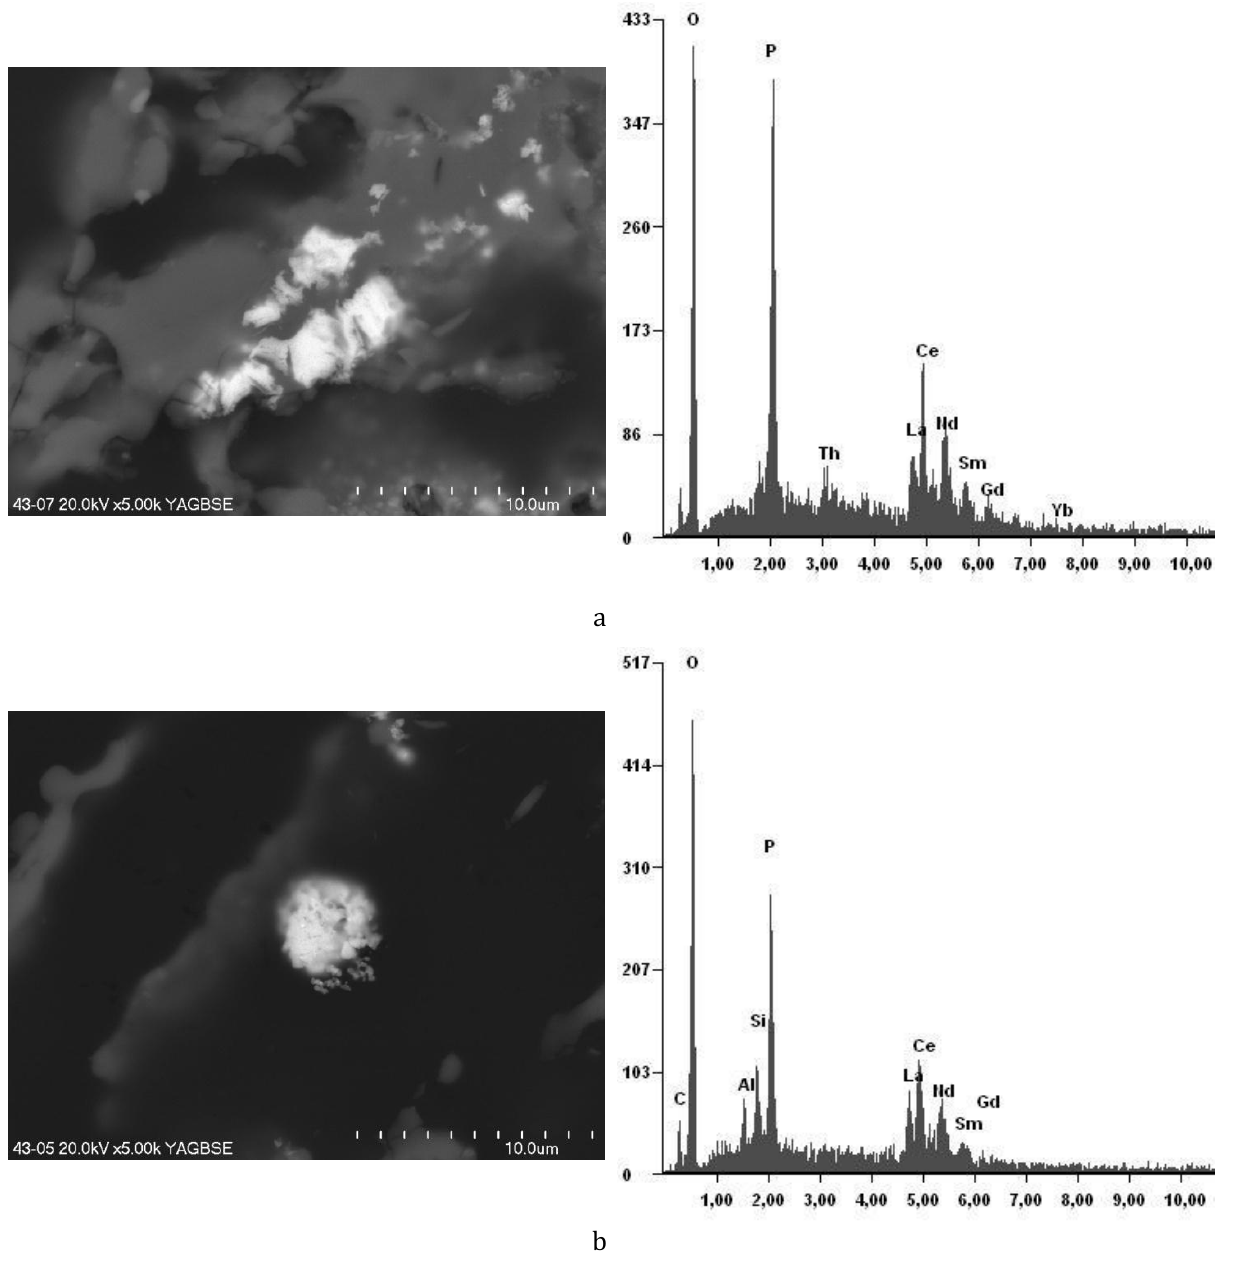
Fig. 4. SEM image and EDS spectrum of monazite in ashes from hard coal (a) and